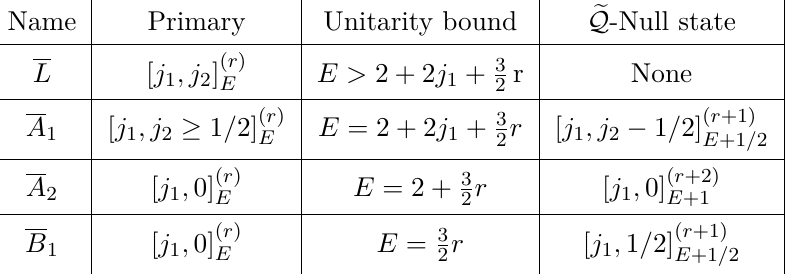
Table 13. e Q -shortening conditions.